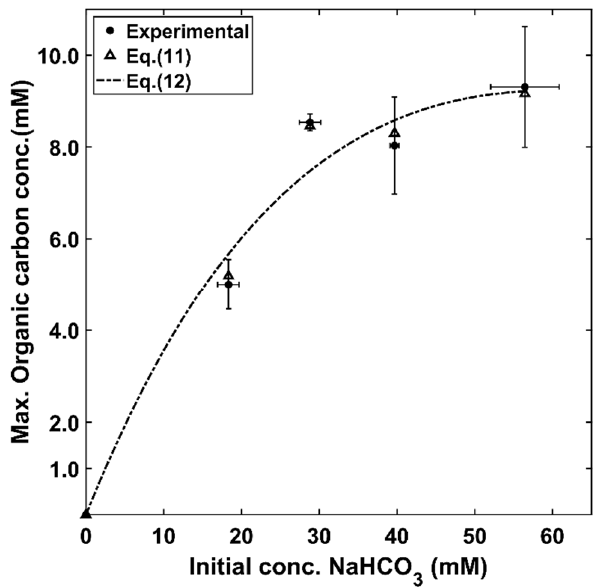
Figure 7. Maximum concentrations of total organic carbon as a function of initial NaHCO 3 . Note: 𝛾 = 0.42 (cid:3399) 0.04 and 𝛿 = 0.02 (cid:3399) 0.004 of Equation (12). γ = 0.42 ± 0.04 and δ = 0.02 ± 0.004 of Equation